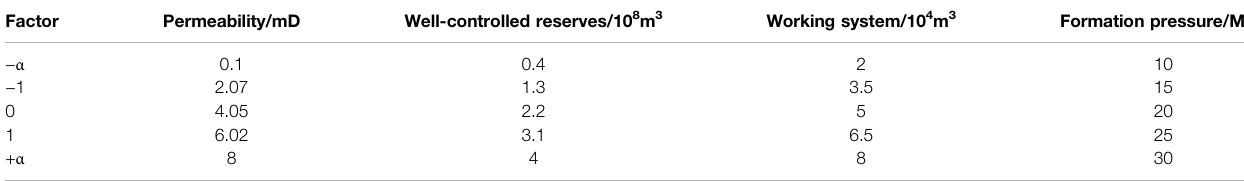
TABLE 2 | Response surface of 4 factors and result of 5 Levels.